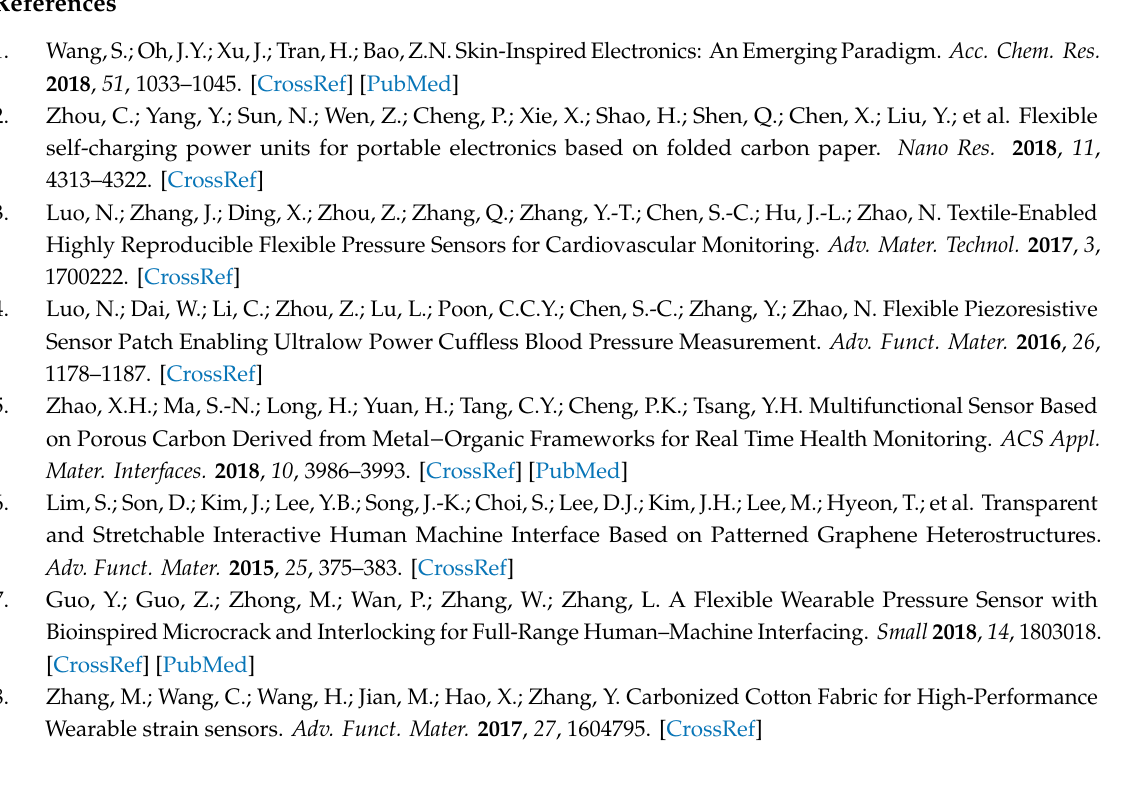
Table S1: Sheet resistance of the polyaniline (PANI) coated fabric, Table S2: Comparison of reported flexible pressure